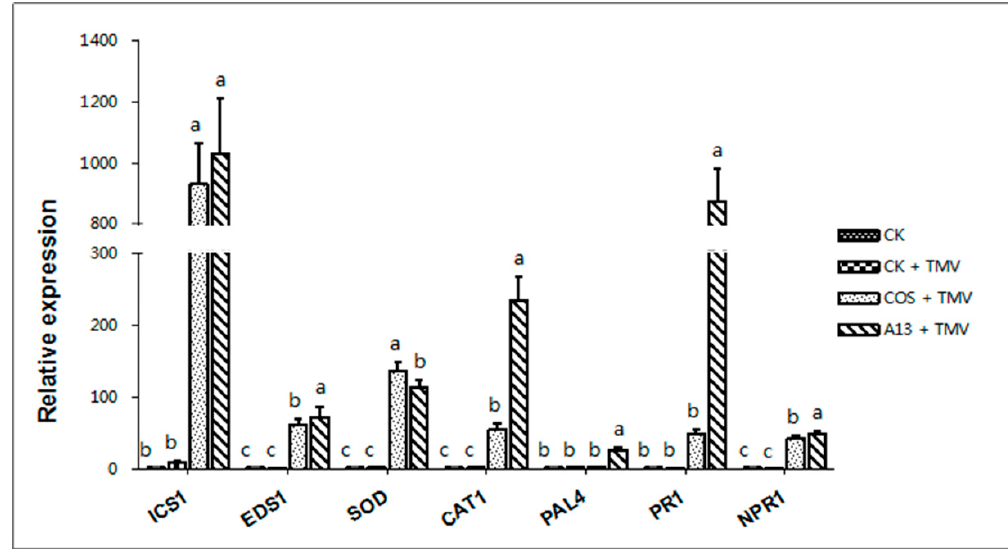
Figure 4. The expression of the defense-related genes was evaluated by RT-qPCR. The relative expression of the defense-related genes, including ICS1 , EDS1 , SOD , CAT1 , PAL4 , PR1 , and NPR1, was highly up-regulated by the A13 + TMV treatment on day 3. Bars indicate the mean of three replicates with the standard deviations. Different letters on the bars indicate statistically significant differences in average values by one-way ANOVA ( p < 0.05).